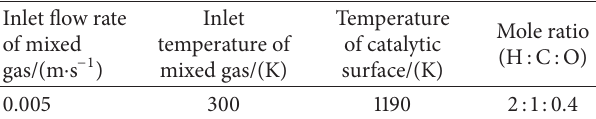
Table 1: The basic operating parameters.